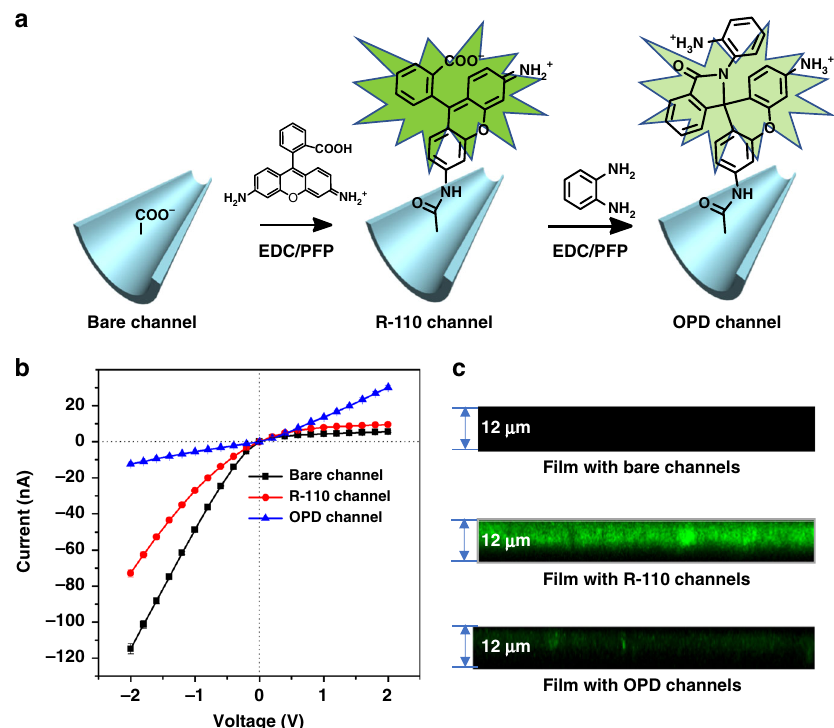
Fig. 2 Fabrication of the NO-regulated nanochannel. a Process for the construction of the NO-gated nanochannel by using a spiro ring opening/closing reaction strategy; b I − V properties of the single nanochannel before and after modi fi cation in 0.1 M KCl; c LSCM observation of the fl uorescent signals before and after R-110 and OPD modi fi cation. LSCM laser-scanning confocal